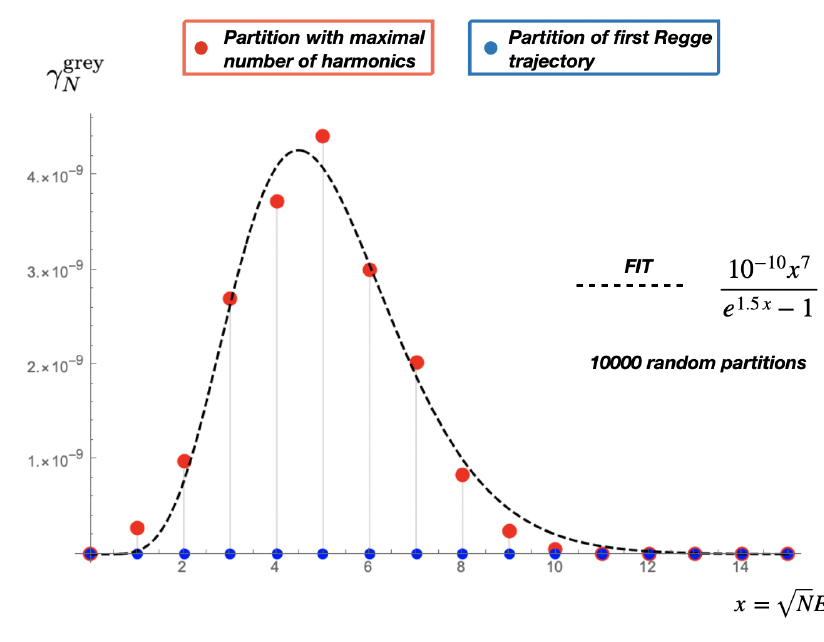
Figure 13 . Spectra of microstates of N = 100 . Comparison between the spectrum of the first Regge trajectory (blue points) and the spectrum of the state with the maximal number of harmonics (red points). The black dashed line represents the fitted behavior of the red spectrum. Table 1 . Table of specific microstates and parameters of (2.14) relative to the spectra of figure 14. microstate with the maximal number of harmonics and the extreme case of the first Regge trajectory (figure 13). As expected the spectrum of a state of the FRtj is not thermal. A complementary picture of the thermal spectrum of string microstates is given in figure 14, where many spectra are presented, classified by different microstates and values of the occupation number J . The specific parameters of (2.14) are reported in table